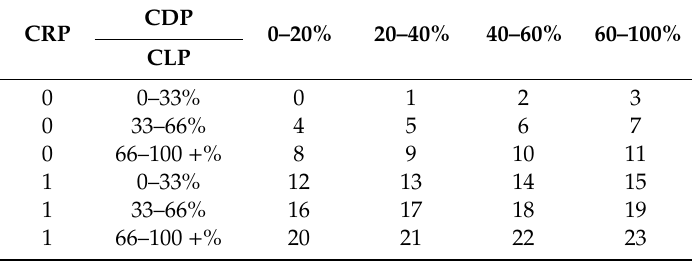
Table 5. Discretized representation of the state